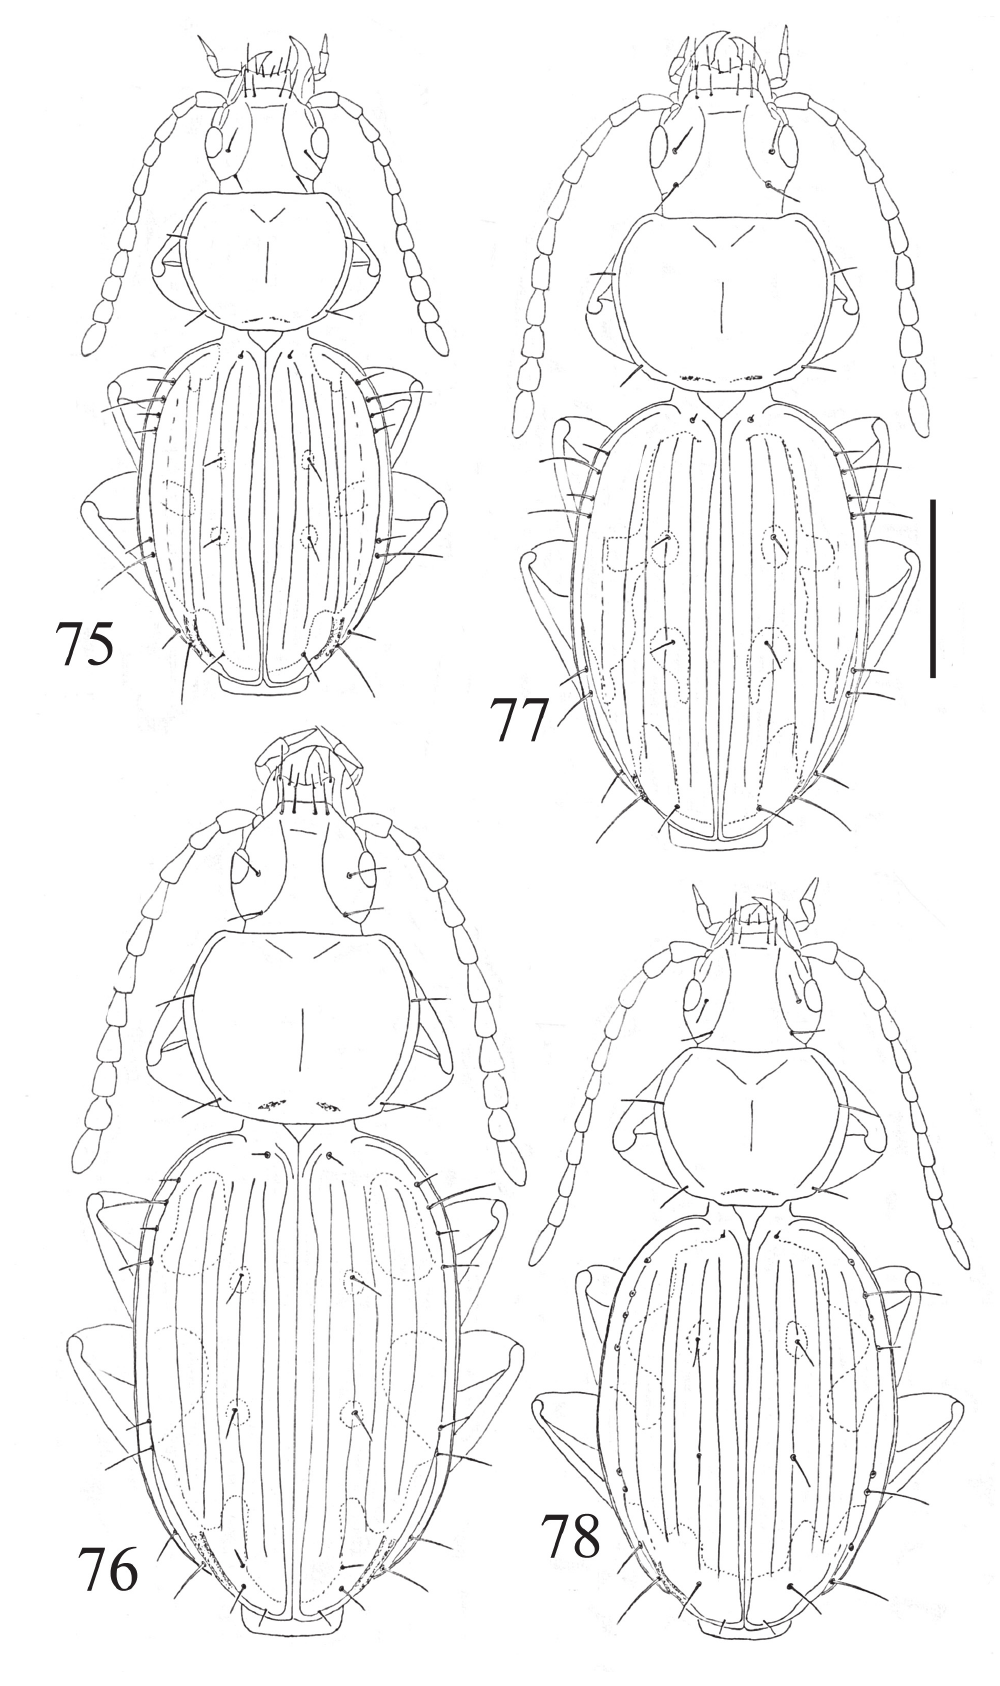
Figs 75-78. Habitus of Trechistus spp.: 75) T. terricola Moore, ♂ from Lake Osborne; 76) T. humicola Moore, ♂ from Mt. Welling- ton; 77) T. gordoni n. sp., HT ♂ from Creepy Crawly Walk; 78) T. sylvaticus Moore, ♂ from Capricorn Cave. Scale: 1